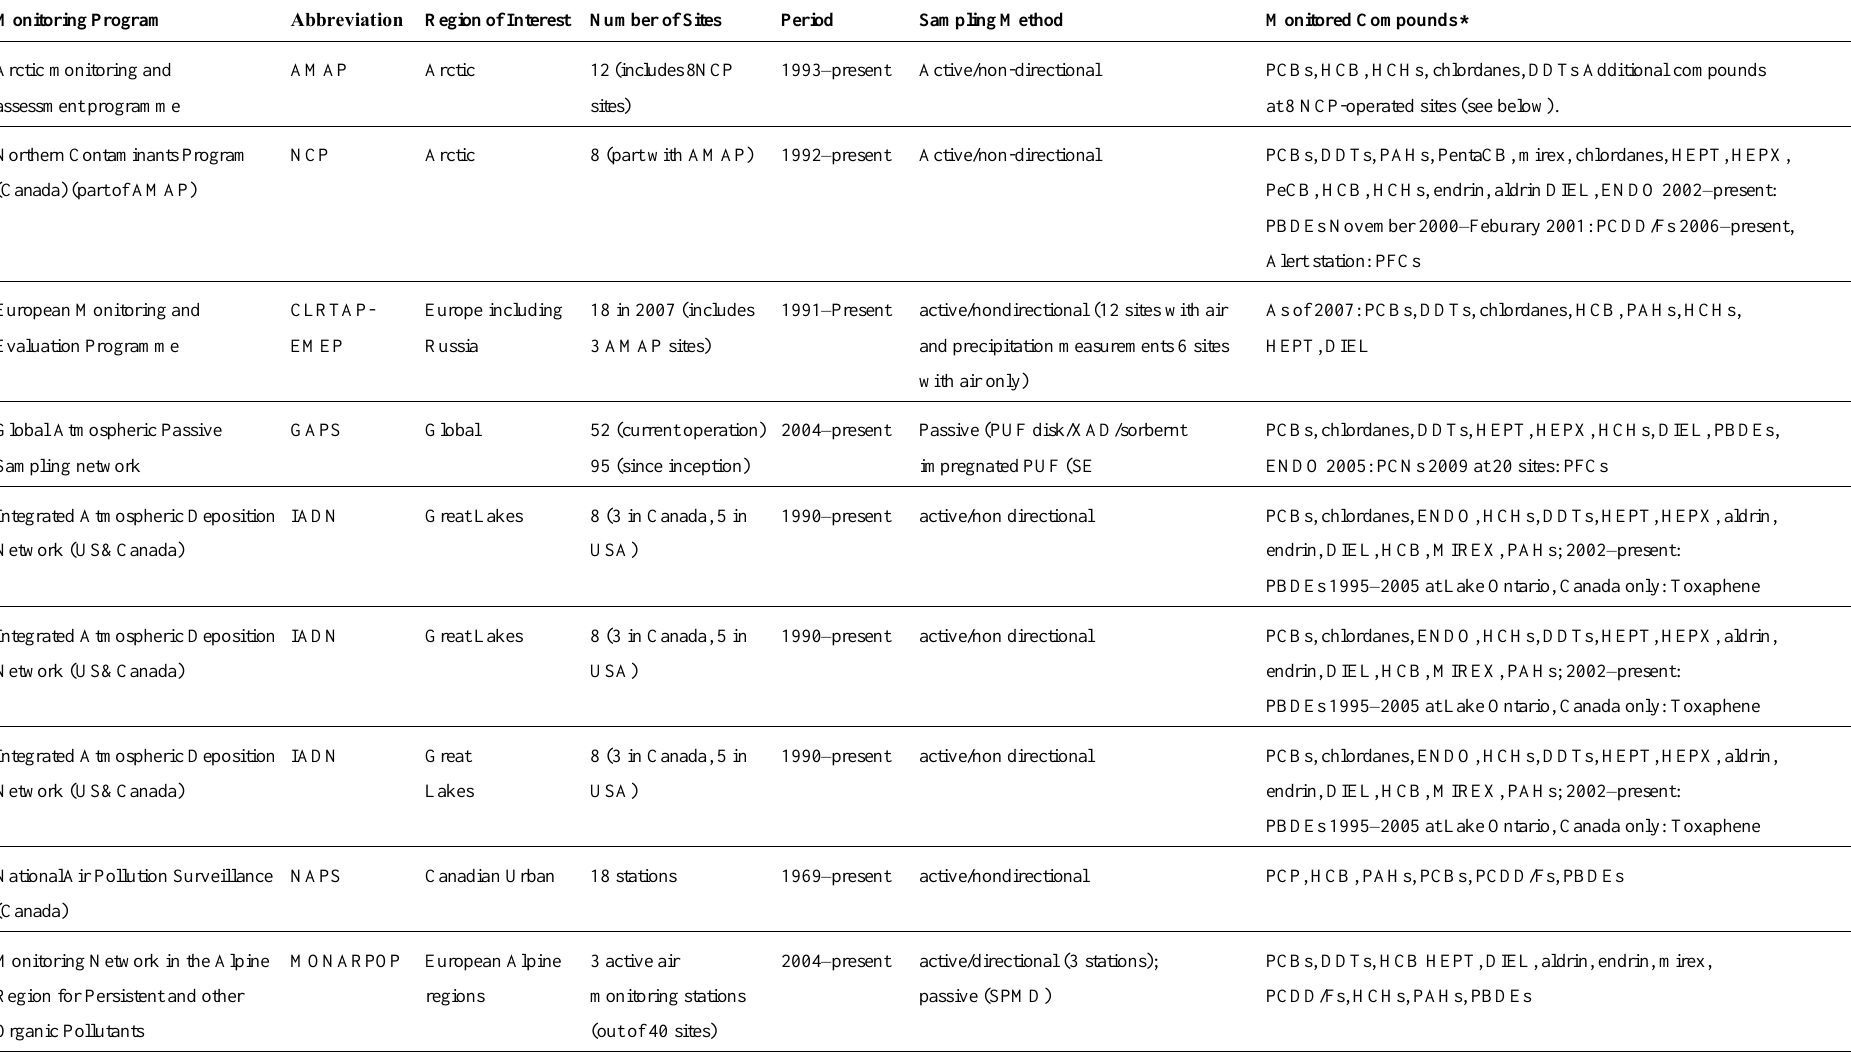
Table 1. Adapted from Table A.2.1. (pp. 195–197) in Appendix A of Chapter 2 of UNECE (2010) [4], lists major programs monitoring POPs in air, the methods and substances monitored that contributed to the SC GMP 2009